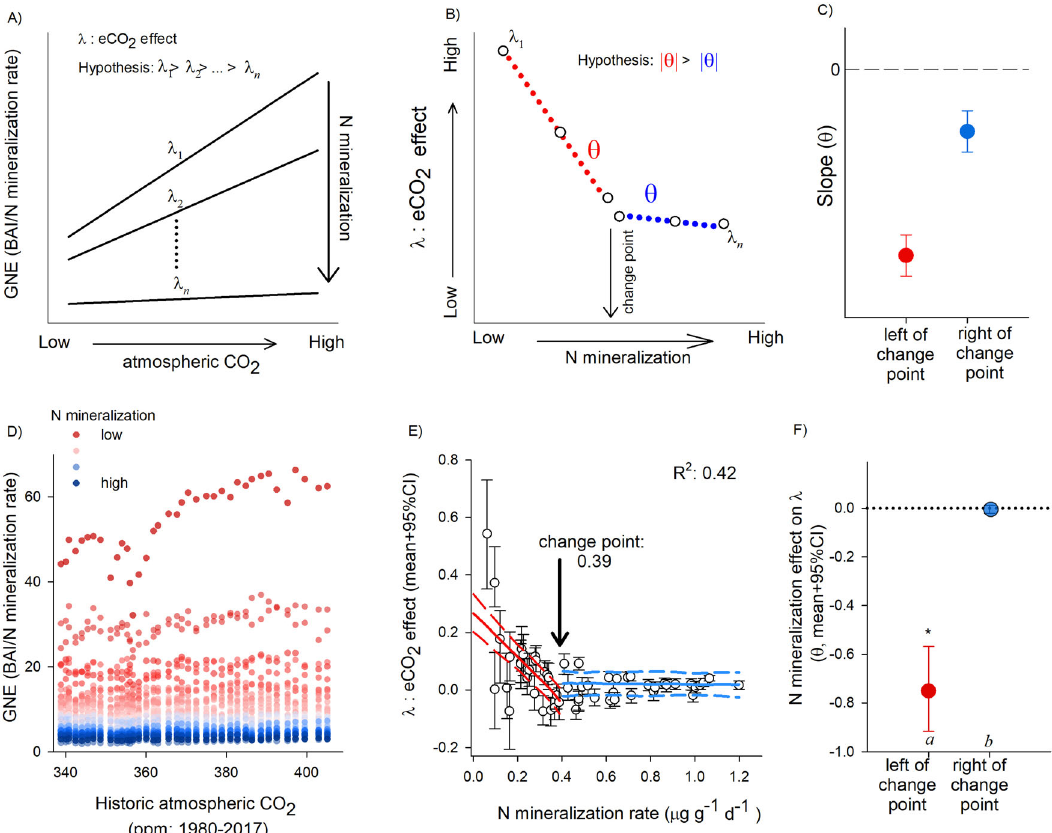
Fig. 4 Analysis framework and evidence for context-dependent iCO 2 fertilization responses. A Representative analysis framework of growth-nitrogen ef fi ciency index (GNE) as a function of increasing concentrations of historic atmospheric CO 2 at each point along the net N mineralization gradient (different lines and their relative slopes). B Conceptual diagram of the effects of iCO 2 ( λ ) on plant growth; change point analysis can detect an in fl ection point along the soil gradient, if any. C Differences in θ derived from the red and blue portion of panel B, indicate distinct slope values. D Dendrochronological data collected from 54 Q. rubra trees from the past 38 years. Individual points represent estimated annual GNE values colored by tree-speci fi c rates of net-N mineralization. E Individual points represent individual trees response to iCO 2 (mean model slopes derived from D ) over the study period. Red and blue lines denote Bayesian change-point model with plotted 95% PI (dashed lines; estimated at average values of other covariates) ( n = 54). F Denotes mean and 95% CI for the red and blue slopes depicted in E ; different letters denote signi fi cant differences between slopes, asterisks indicate signi fi cant differences from zero (95% CI do not include zero; n =